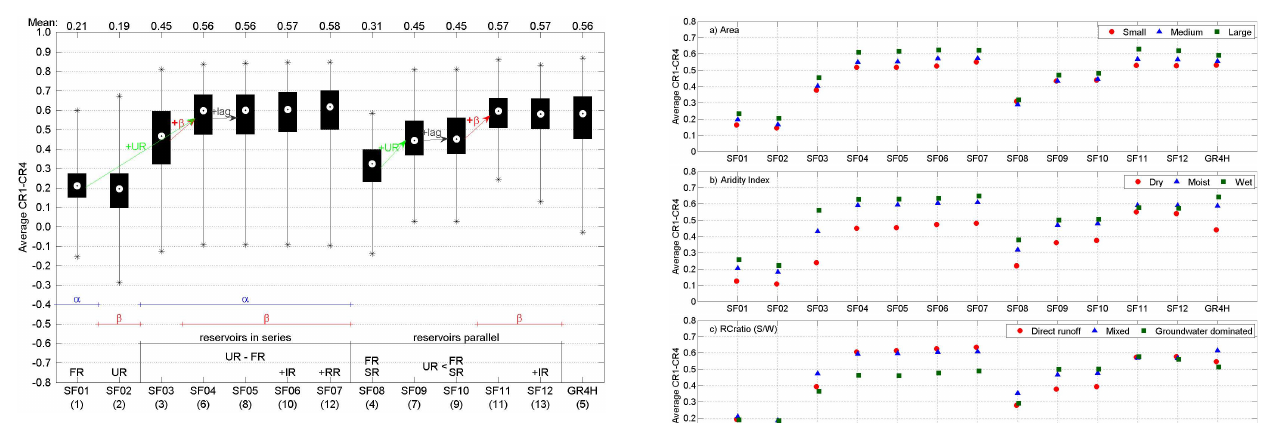
Fig. 3. Box plots (maximum, 75th percentile, median, 25th per- centile and minimum) of averaged CR1–CR4 values of all model structures on the 237 catchments in the validation periods, includ- ing notes on differences in SUPERFLEX structures. Where “ + β ” means adding a power function β , “ + lag” means adding a lag- function, UR = unsaturated zone reservoir, FR = fast reservoir, SR = slow reservoir, IR = interception reservoir and RR = riparian zone reservoir. The x axis shows the twelve SUPERFLEX struc- tures plus GR4H. The number of model parameters (used as a mea- sure of complexity) is given in brackets after the model name. The numbers across the top of the figure give the mean values of model performance.